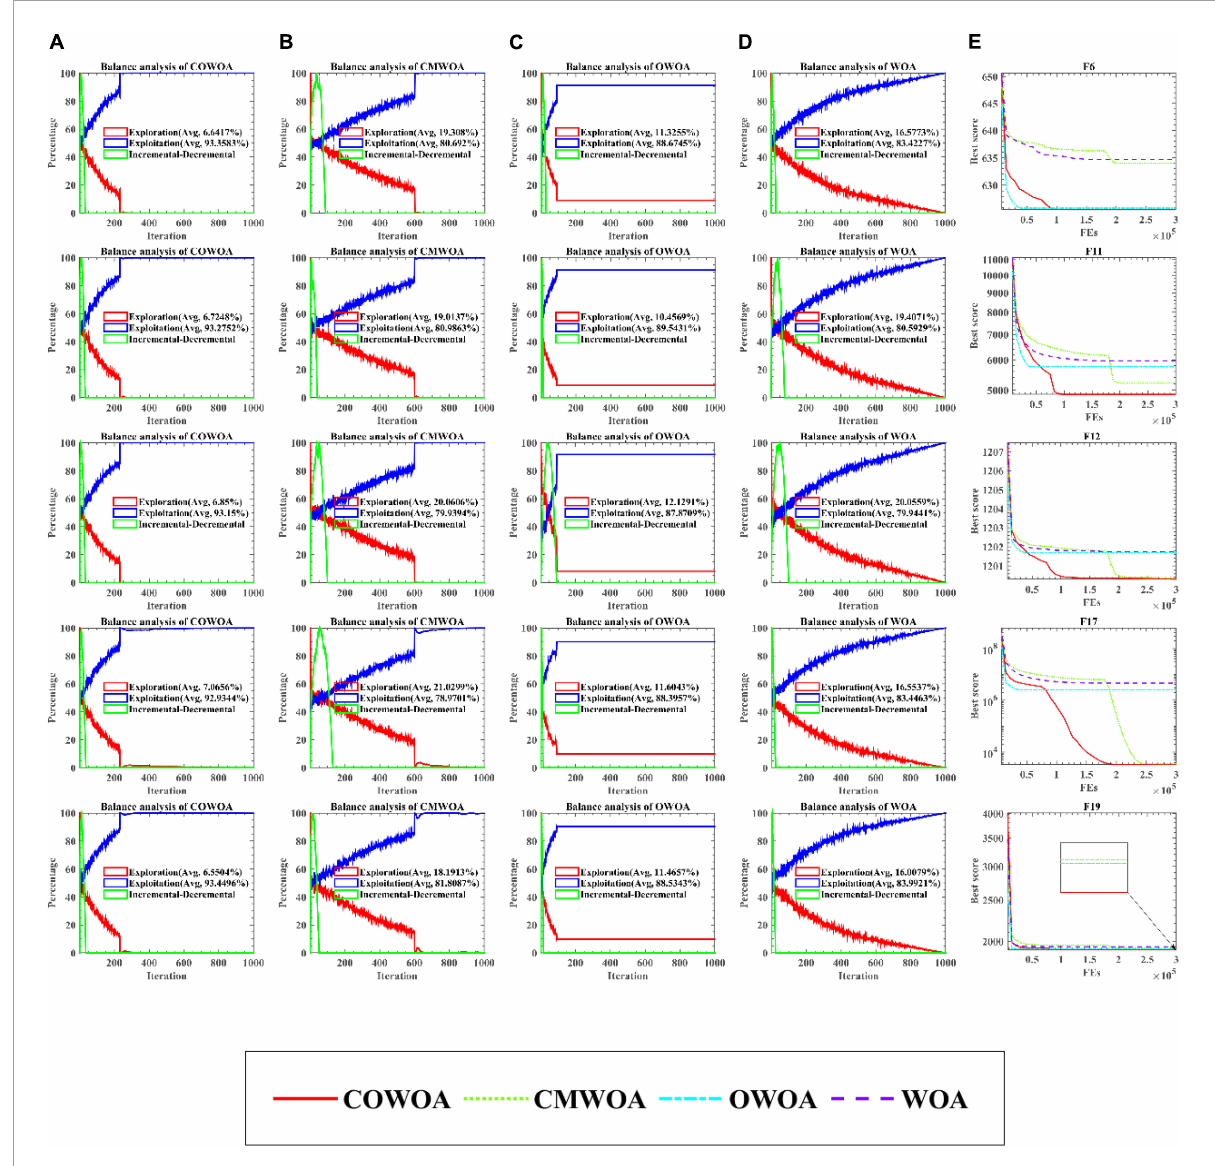
FIGURE6 The balance analysis results of COWOA, CMWOA, OWOA, and